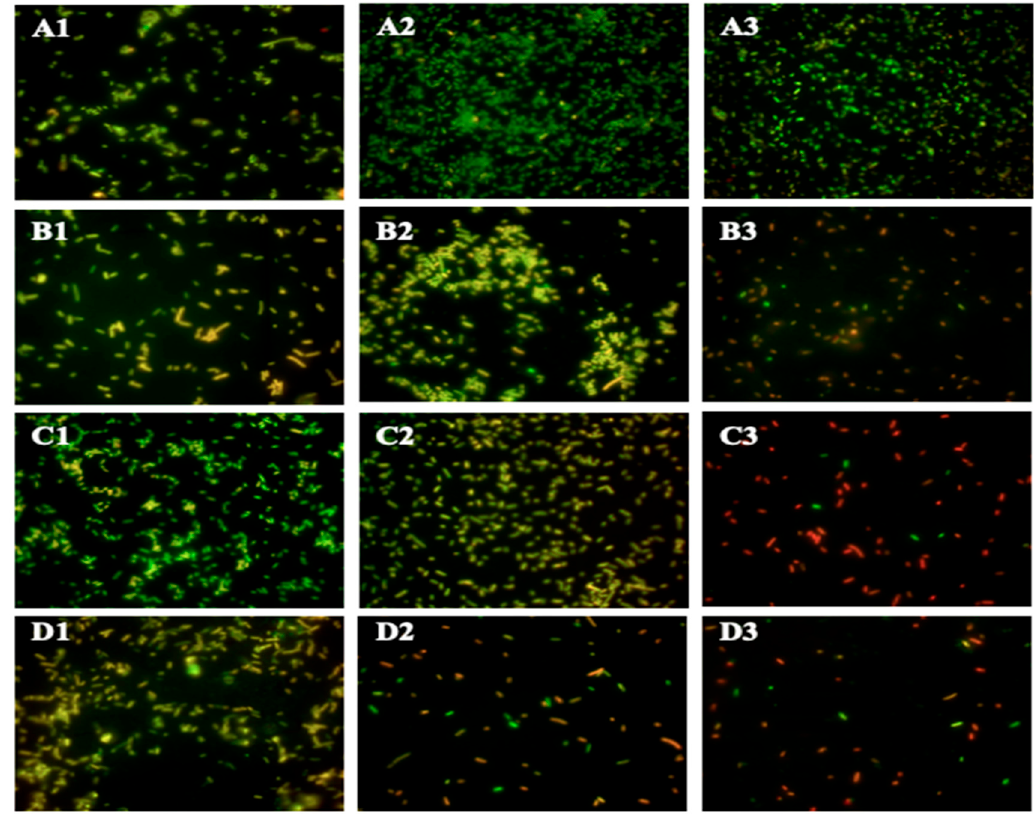
Figure 4. Observing changes in membrane permeabilization through fluorescent microscopy with dyes SYTO9 and PI for negative control ( A1–A3 ), GA ( B1–B3 ), PA ( C1–C3 ), VA ( D1–D3 ) over 4 (1), 8 (2) and 24 (3) h of treatment periods.